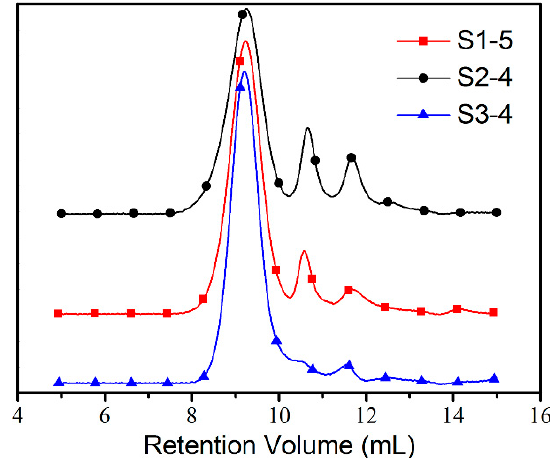
Figure 2. The GPC curves of the fractions ( S1-5 , S2-4 and S3-4 ) of HPManEMA- co -MBA.